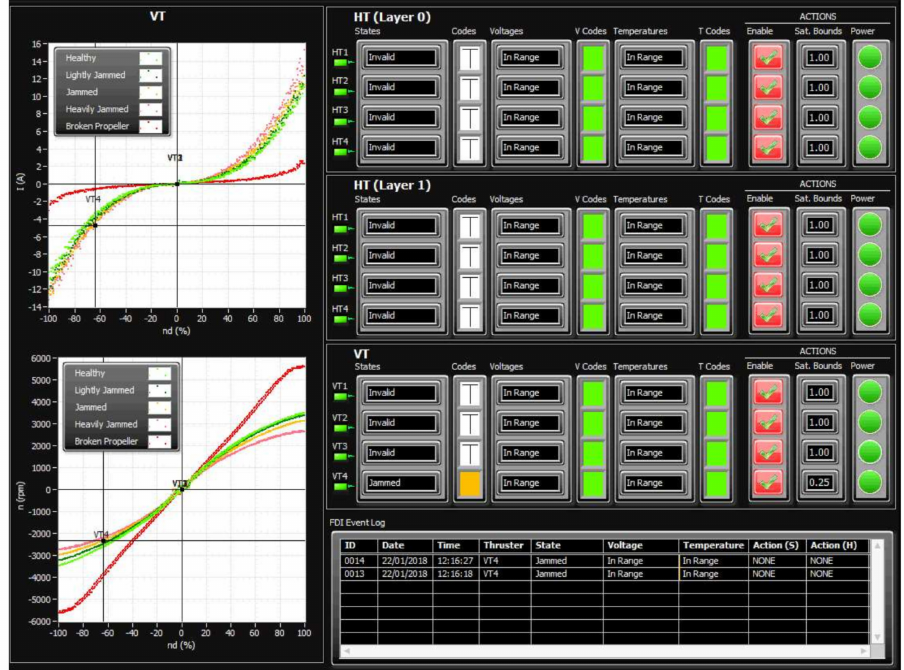
Figure 18. Thruster FDI result for thruster state =